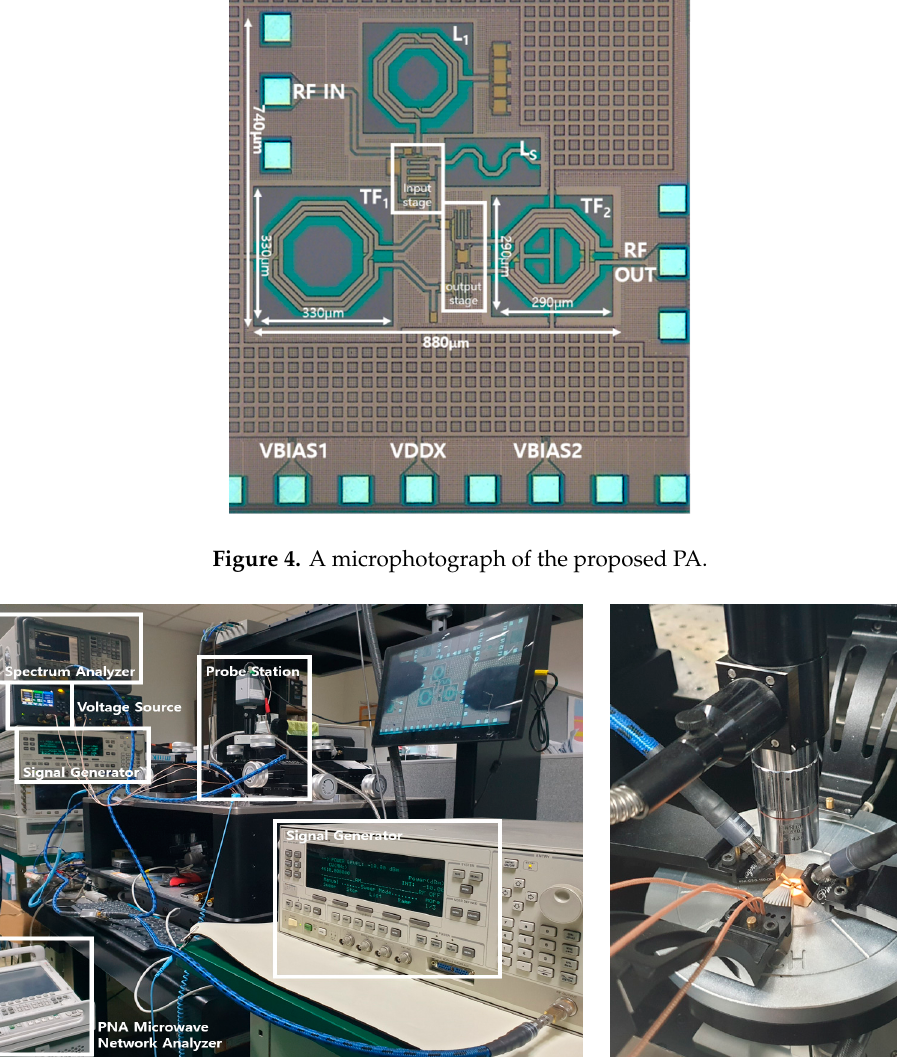
Figure 6. The simulated and measured S-parameters of the proposed PA. The output-referred 1 dB compression point (OP1dB) and the PAE were measured with an Agilent E4405B spectrum analyzer and an Agilent 83623B signal generator. The results show that the OP1dB was 13 dBm, P SAT was 15.4 dBm, and the peak PAE was 15% when the input power was -1.5 dBm, as depicted in Figure 7. Figure 8 presents the measured output signal of the proposed PA when intermodulation was performed with a 5 MHz frequency offset, while Figure 9 shows the measured third-order intercept point (IP3) of the implemented PA (the simulated input-referred IP3 (IIP3) was 8 dBm); the measured output-referred IP3 (OIP3) was 24.5 dBm, while the measured IIP3 was 6.5 dBm and the measured OIP3 was 22 dBm.